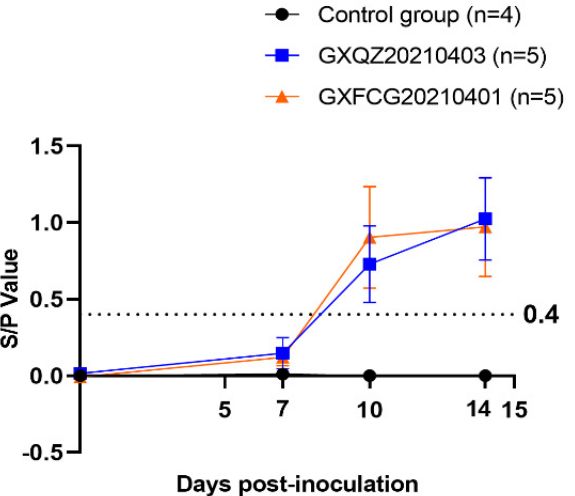
Figure 6. PRRSV-specific N protein antibodies in sera from pigs challenged for different days after infection. The cut-off value for seroconversion was set at a sample-to-positive (s/p) ratio of 0.4. The values are expressed as means ± standard deviations.